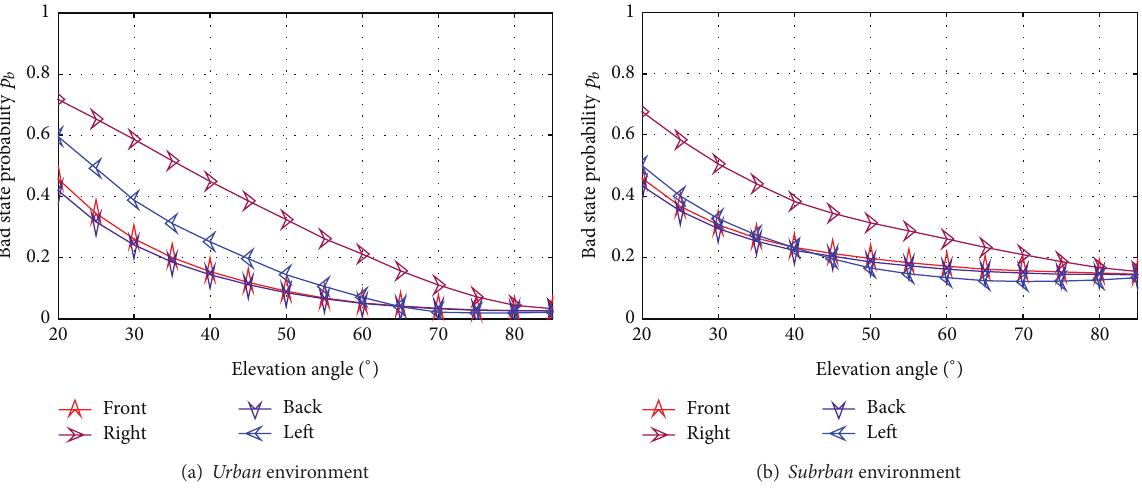
Figure 12: Bad state probability 𝑝 𝑏 for different driving directions in urban (a) and suburban (b)